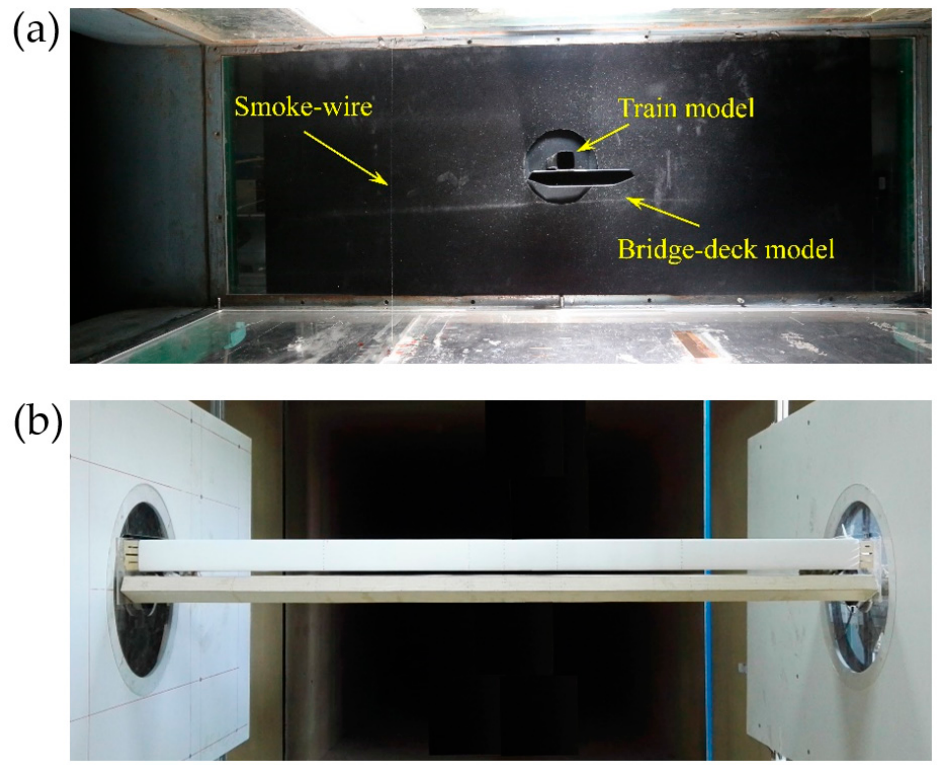
Figure 1. Mode installations: ( a ) Models for flow visualization, and ( b ) Models for pressure field and flow profile measurements.